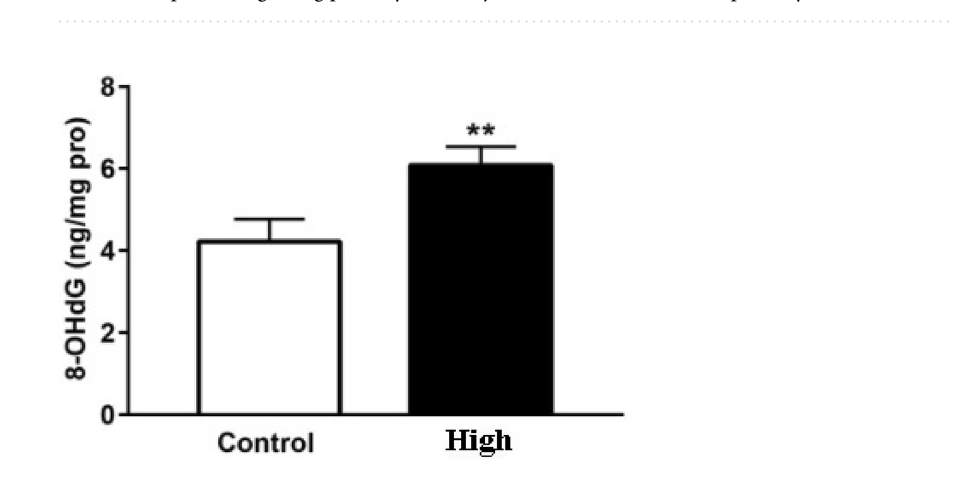
Table 3. Important signaling pathways and major DEGs involved in these pathways.